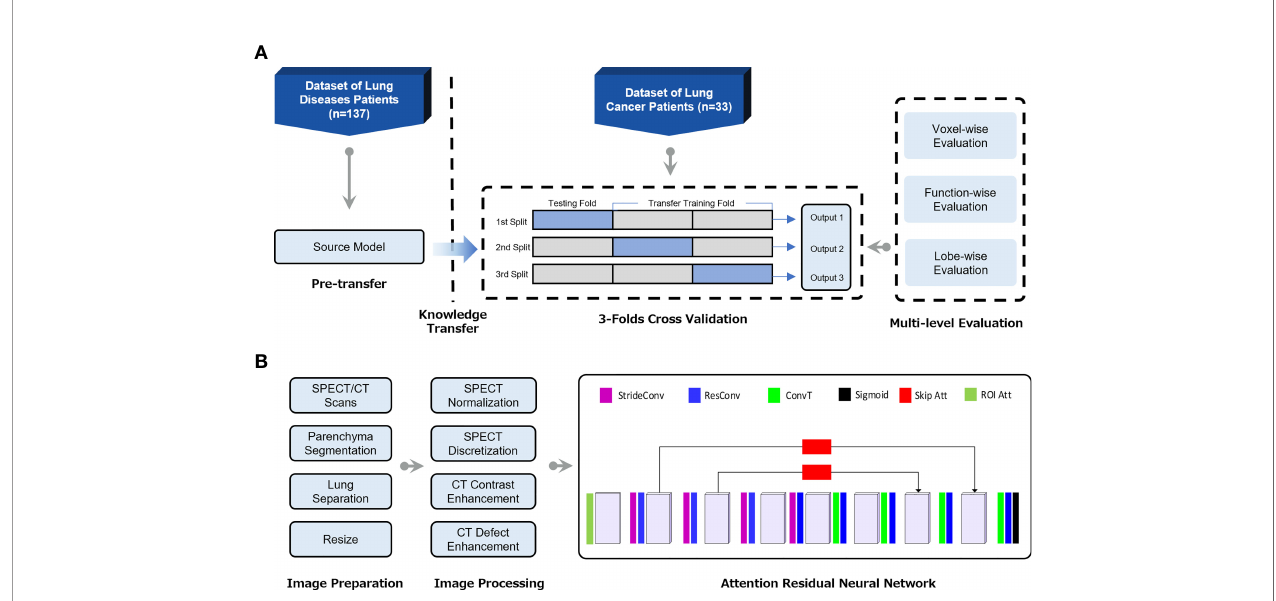
FIGURE 1 | (A) Flow chart of the transfer learning framework for generation of CT-based perfusion images on lung cancer patients. (B) The pipeline of deep learning-based CT-to-perfusion mapping (CTPM)